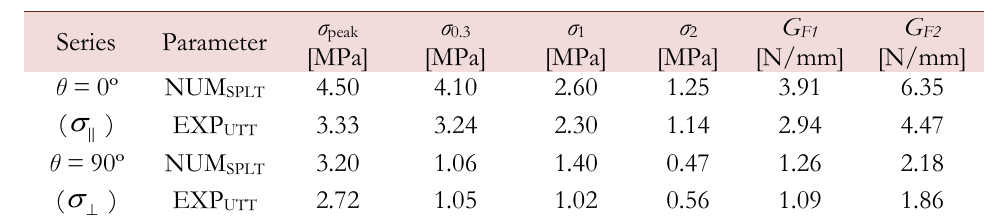
Table 5: Residual stress and toughness parameters obtained from different analysis.